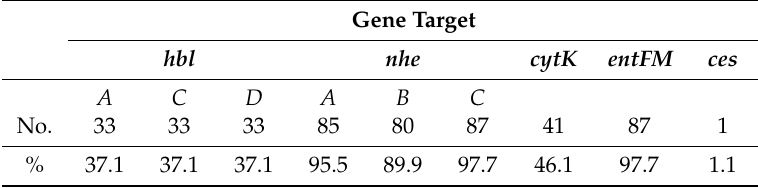
Table 4. Number (No.) and percentage (%) of B-cereus strains containing nine genes ( hblA , hblC , hblD , nheA , nheB , nheC , cytK , entFM and ces ) encoding five toxins (HBL, NHE, CytK, EntFM and Ces). Gene Target hbl nhe